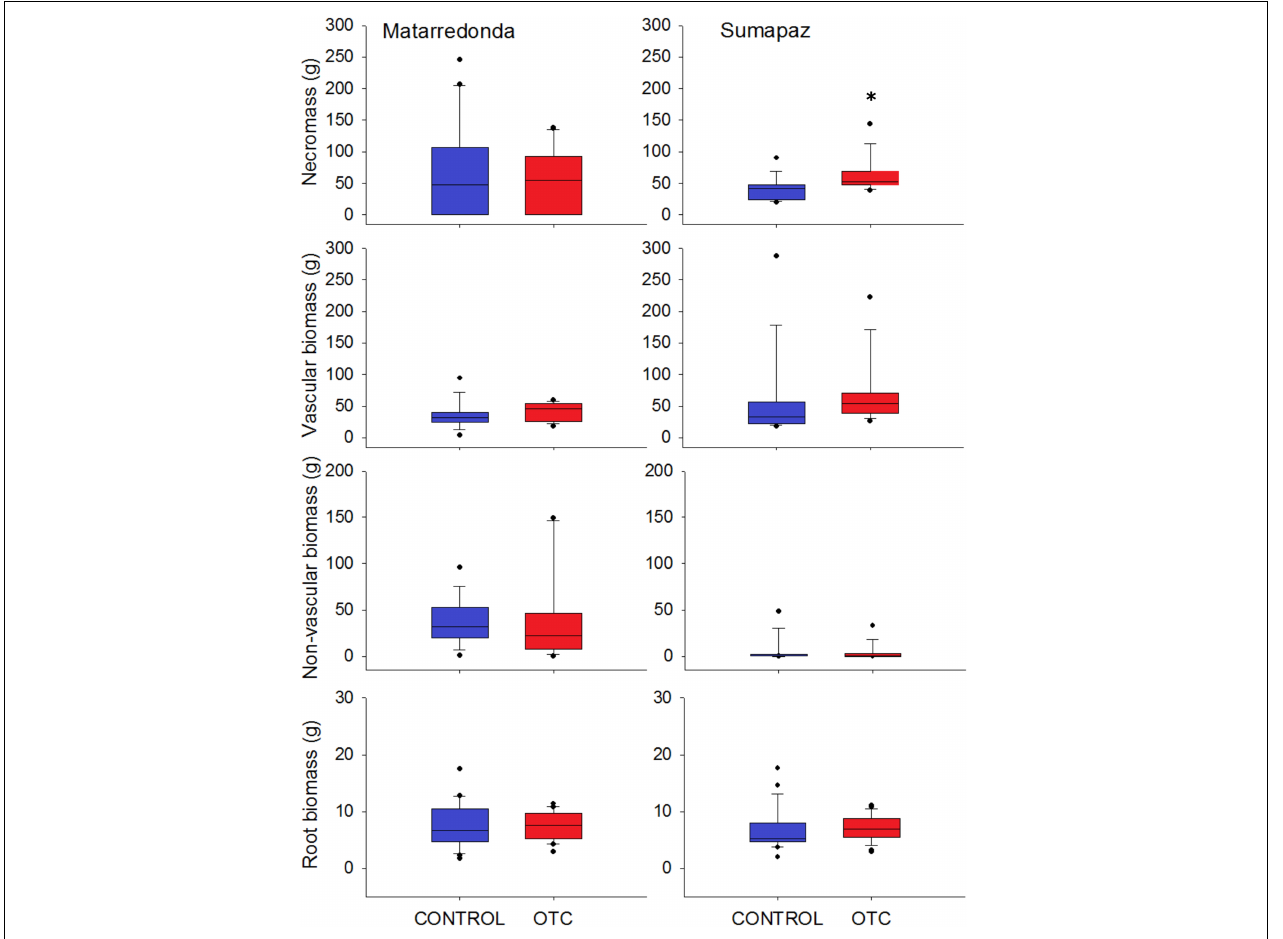
FIGURE 6 | Aboveground biomass separated by vegetation type [vascular, non-vascular plants, and necromass found in a 1 m × 10 cm strip on each plot ( n = 10) and below ground biomass collected from 2 soil cores of 15 cm × 5 cm extracted from each plot ( n = 20)]. All box plots show the median, 25/75th percentiles within the box, 10/90th percentiles shown within the whiskers and the outlier. Asterisk denote statistically significant differences between OTC and control plots at P <